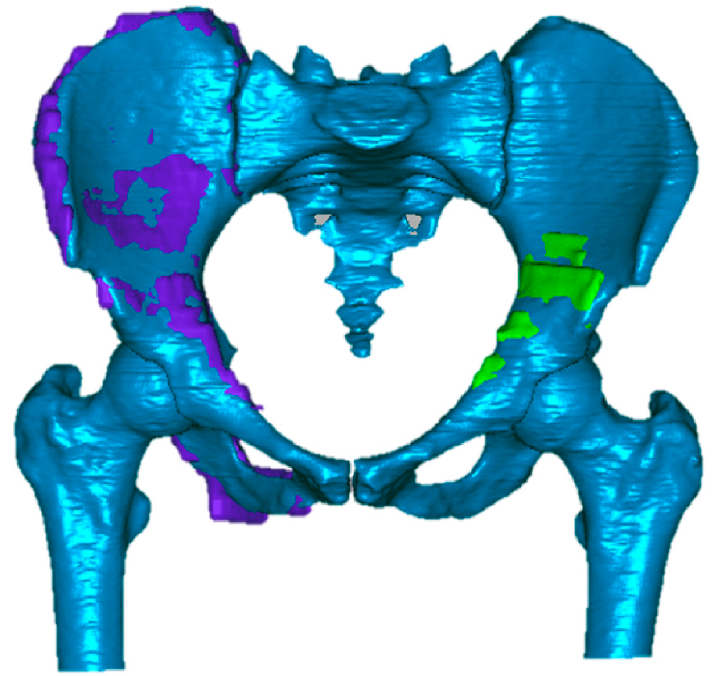
Figure 3. The 3D result after a best-fit registration of the MRI-based models to CT-based models; again, the model of the tumor from MRI is depicted in green.